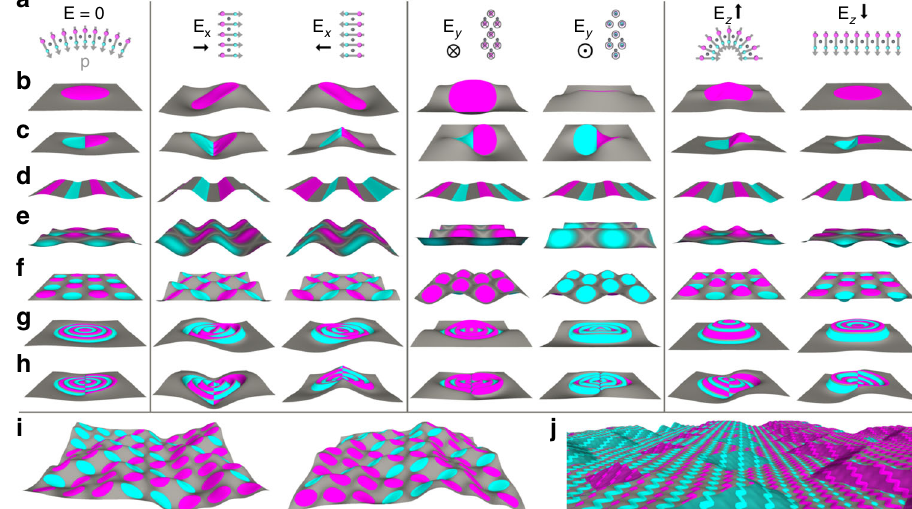
to actuate TMD alloy monolayers with composition-programmed shapes. a Schematics of how Janus regions in Fig. 6 Using applied electric fi elds E A monolayers with clamped edges reorient, bend, or fl atten according to their electric polarity relative to that of the fi eld. Gray, magenta, and cyan spheres represent Mo, S, and Se atoms, respectively. Gray (black) arrows indicate atomic dipole moment (applied electric fi eld) direction. The fi rst column shows equilibrium shapes of seven Janus-patterned free standing sheets in the absence of an applied electric fi eld ( E 0). b – h Simulated shapes of Janus- A ¼ patterned MoSeS monolayers under uniform fi elds with directions shown in ( a ). i ± E x -induced crumpling of a monolayer containing circular Janus domains arranged on a square lattice with randomly assigned polarity. j E x -induced two-scale buckling/folding of a patterned monolayer containing zigzag Janus domains on two length scales. Also see Supplementary Movies 6 –